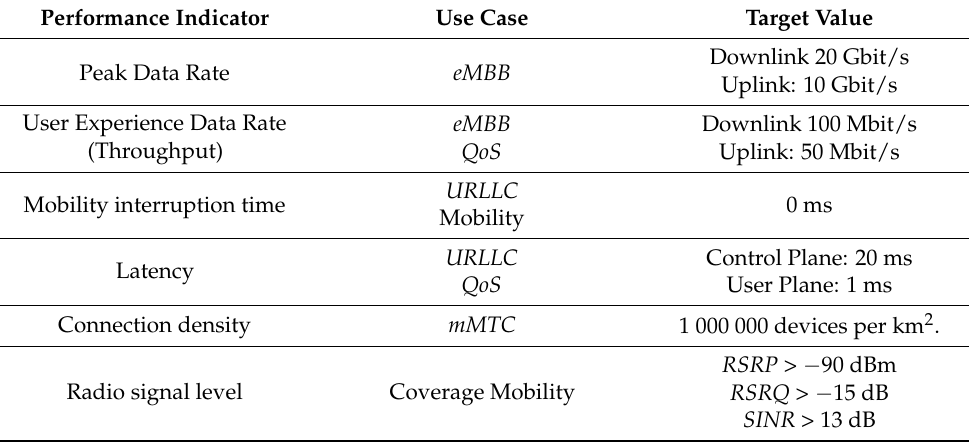
Table 4. Target values of the 5G key performance indicators depending on RAN optimization use